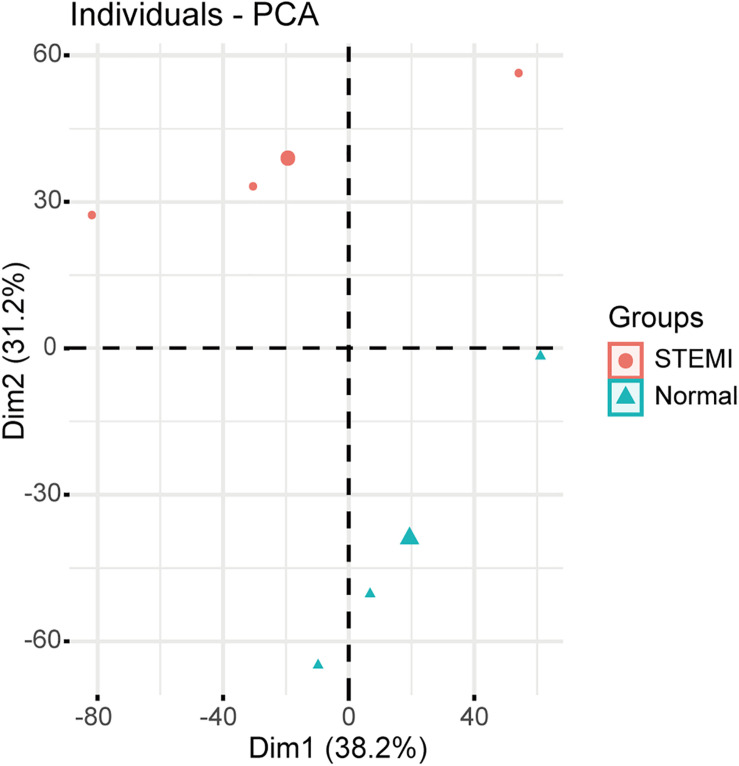
Relative distances between samples from AMI patients (red symbol) and controls (green symbol) by PCA. The top two principal components of the circRNA expression profiles.